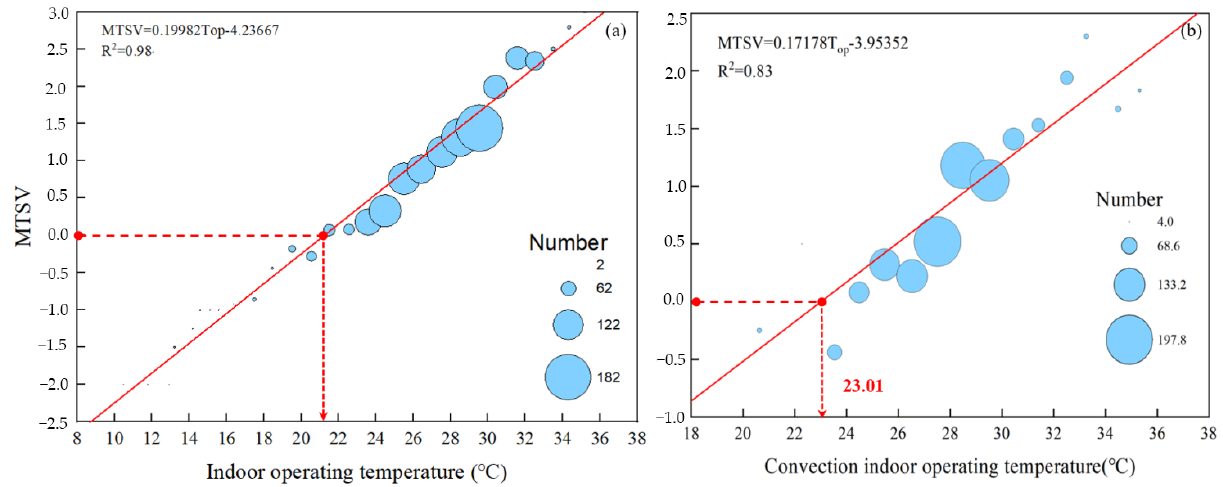
Figure 7. Relationships between the MTSV and T op : ( a ) radiation floor heating, ( b ) convection heating.